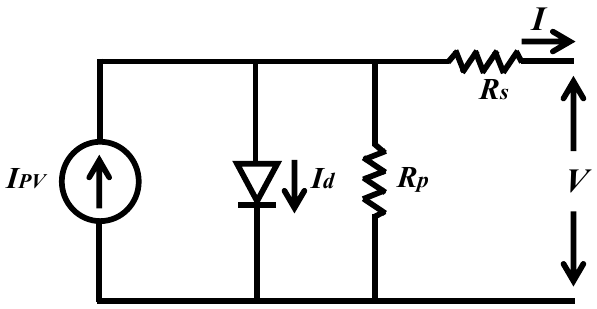
Figure 2. Equivalent circuit diagram of a single diode PV module.